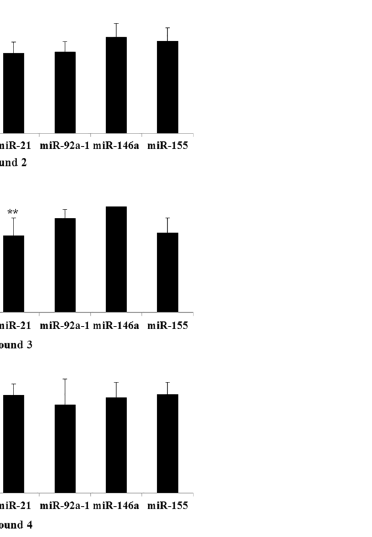
Fig 3. Treatment with compounds induced specific changes in miR-31 expression. Expression levels of miR-15a, 16, 21, 31, 92a-1, 146a, and 155 after treatment of A549 cells with 5 μ M compounds2 (A), 3 (B), and 4 (C) were determined via qRT-PCR. miRNA expressionlevels were normalizedagainst RNU6B ,and the values shown are relative to those of cells treated with DMSO alone.Data are representative of three independent experiments with similar results and are expressedas mean ± SD. ** , p < 0.01; *** , p < 0.001.